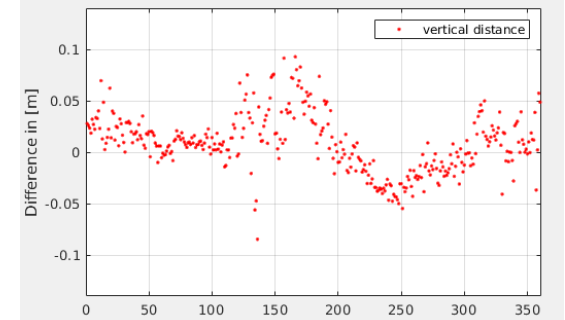
Figure 6. Magnetic sticker with cross installed on vehicle roof ( 1 . 2 m × 0 . 85 m ). GNSS antenna is installed in the center of the cross. Top left: original resolution, top middle: imaged with 10cm GSD, top right: imaged with 7cm GSD.